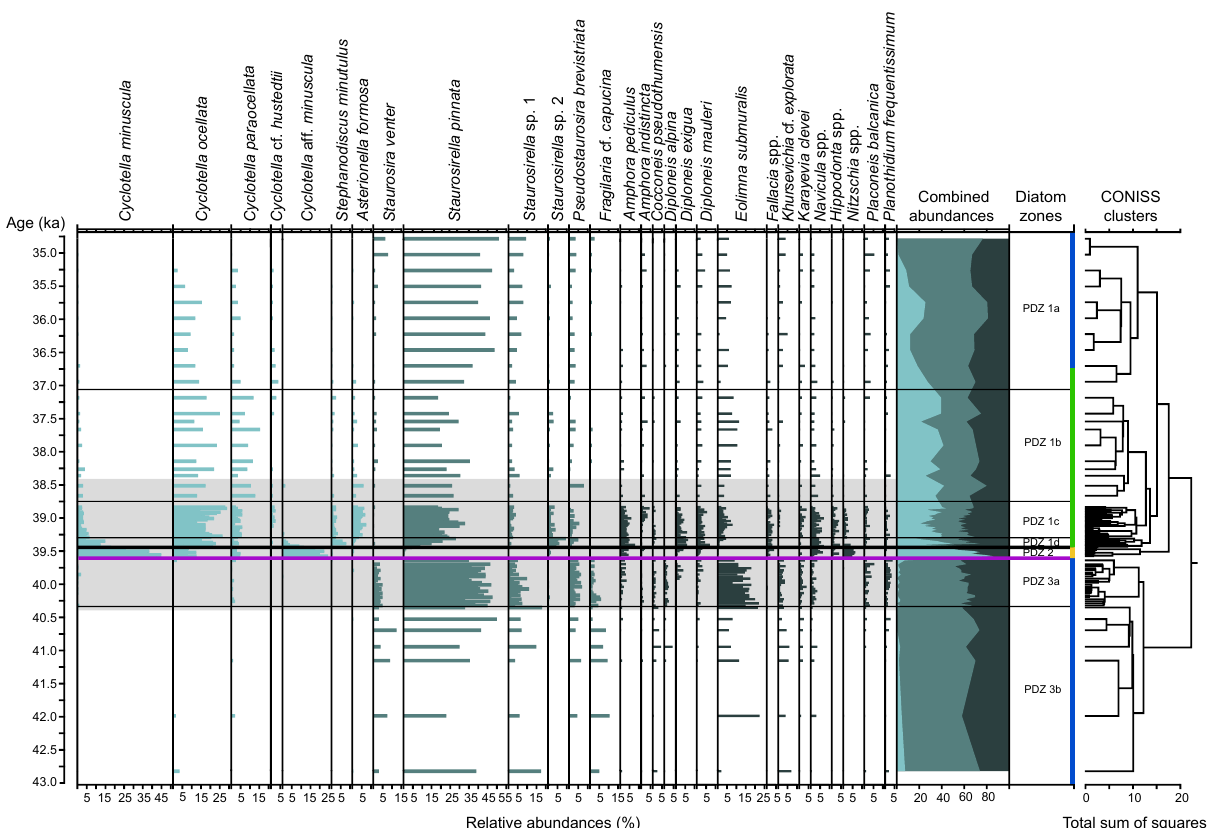
Figure 3. Summary diatom diagram for the Prespa core (Co1204). Only diatom taxa with relative abundances of >4% are shown. Individual abundances are color-coded according to lifestyle (light blueish green: planktonic; medium greyish green: facultative planktonic; dark greyish green: benthic). Diatom zones and subzones were defined by CONISS; zone boundaries are represented with thick solid lines, subzone boundaries with thin solid lines. PAM community clusters are color-coded according to Fig. 4b. The purple line indicates the duration of the Y-5 eruption; the grey-shaded area the timing of the H4 event. Note that the diatom communities had reached the quasi pre-disturbance state (upper blue bar) only after the end of the H4